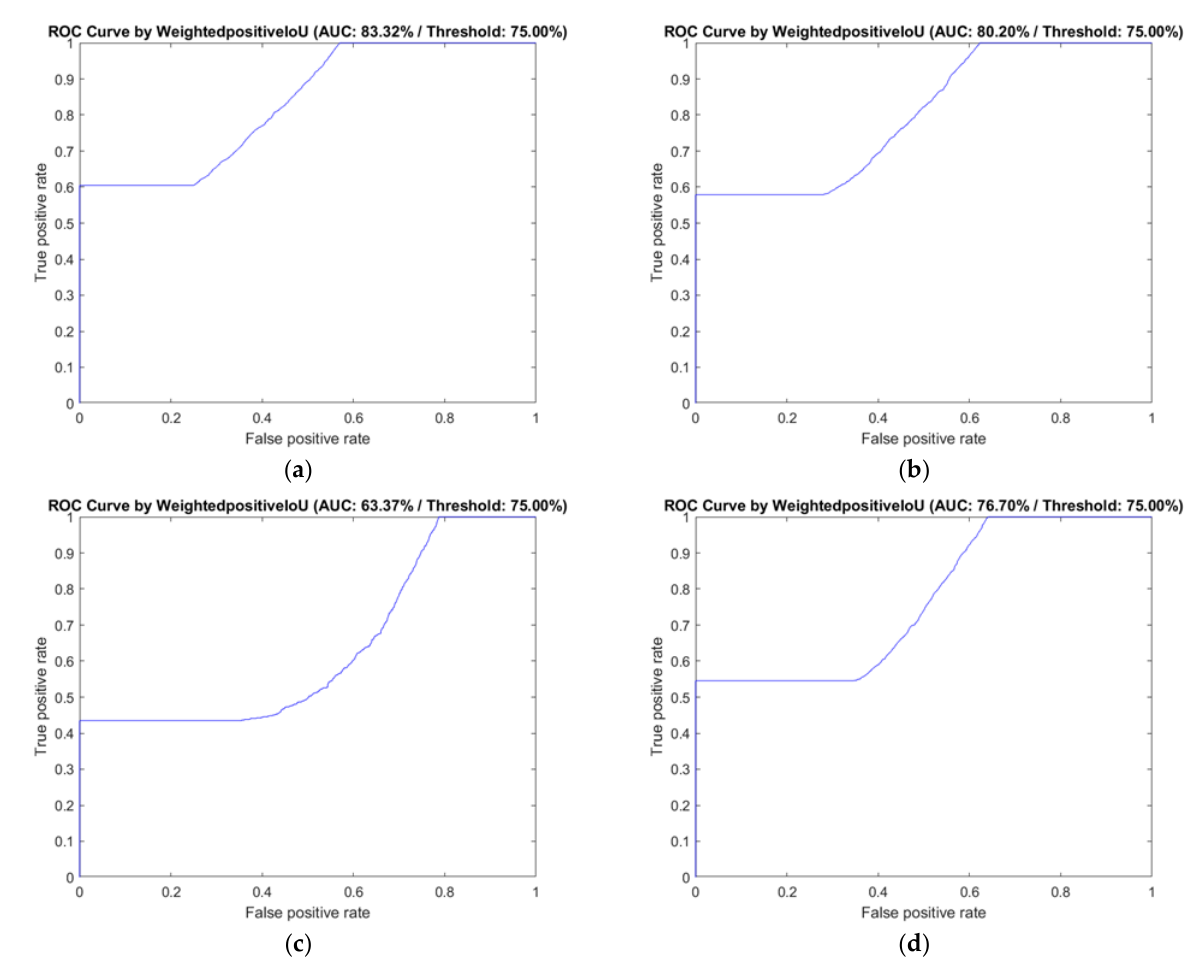
Figure 8. The ROC curve and AUC of the classification performance of DeepLab v3+ with the three selected decoders and FCN-32s, based on the six selected BI-RADS features. BI-RADS: Breast Imaging Reporting and Data System, ROC: receiver operating characteristic curve, AUC: area under curve. ( a ) Classification performance of DeepLab v3+ with ResNet-50; ( b ) classification performance of DeepLab v3+ with Inception-ResNet-v2; ( c) classification performance of DeepLab v3+ with MobileNet-v2; ( d ) classification performance of FCN-32s.